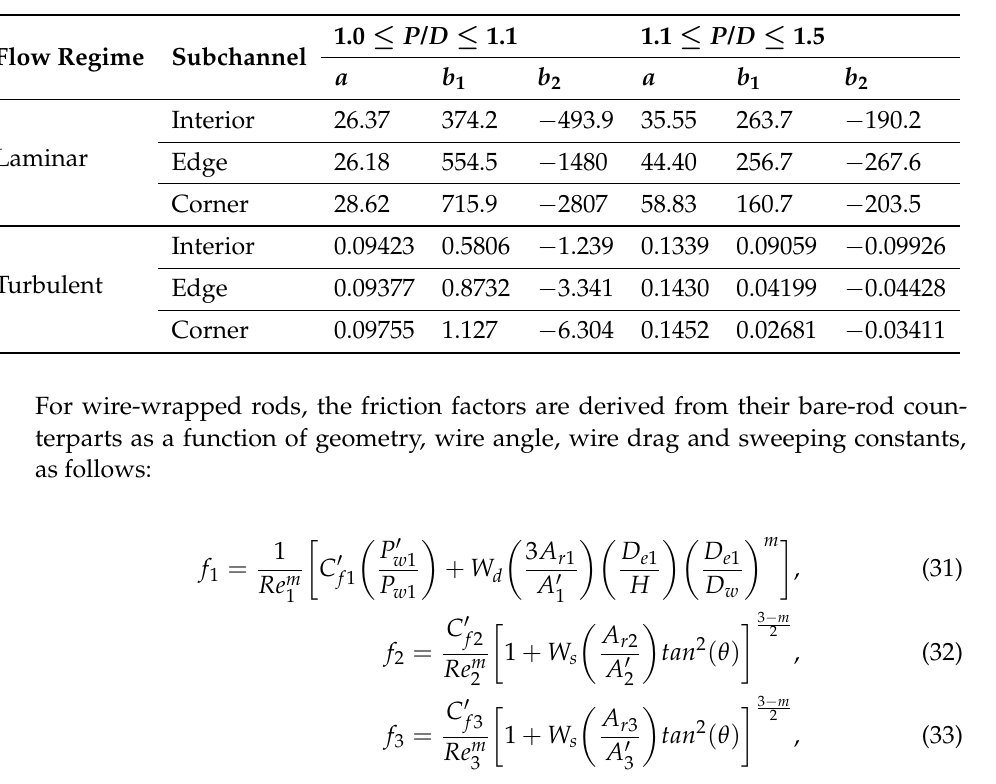
Table 2. Coefficients for bare rod subchannel friction factor constants in square